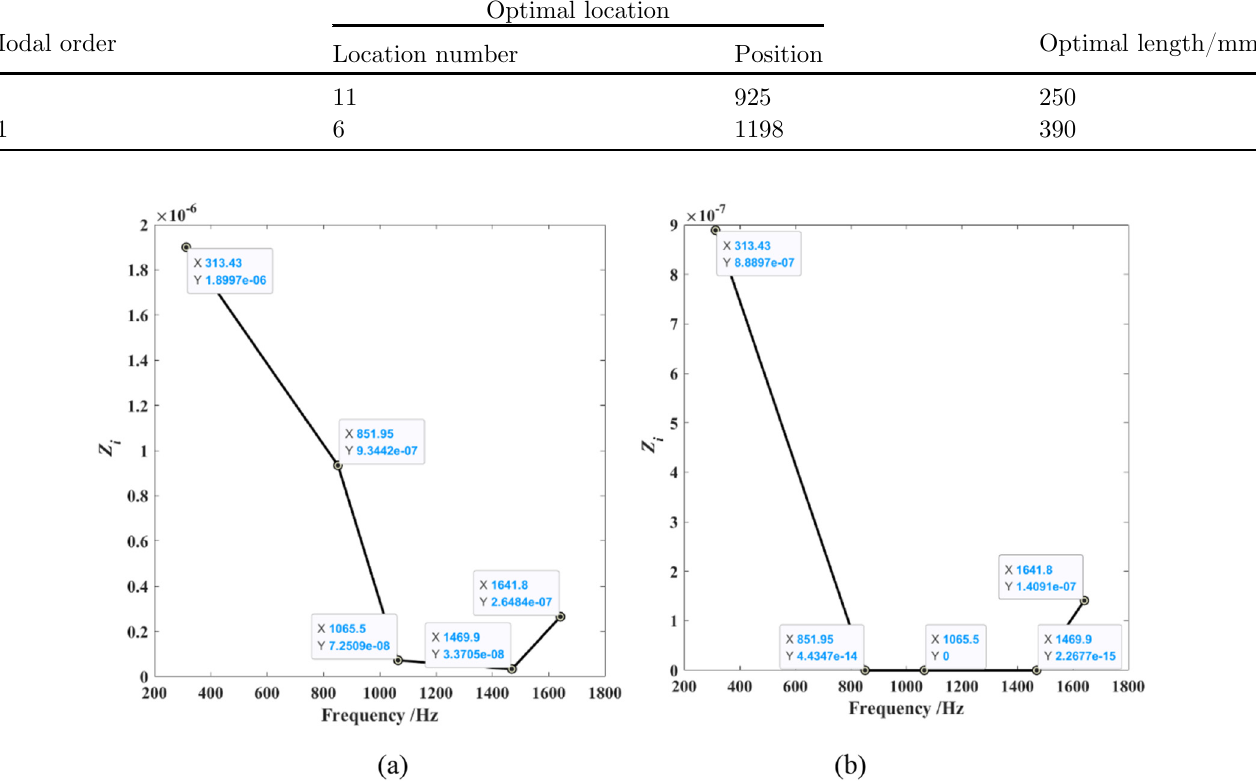
Fig. 6. Critical mode ordering: (a) under the force-free constraints; (b) under the force constraints.